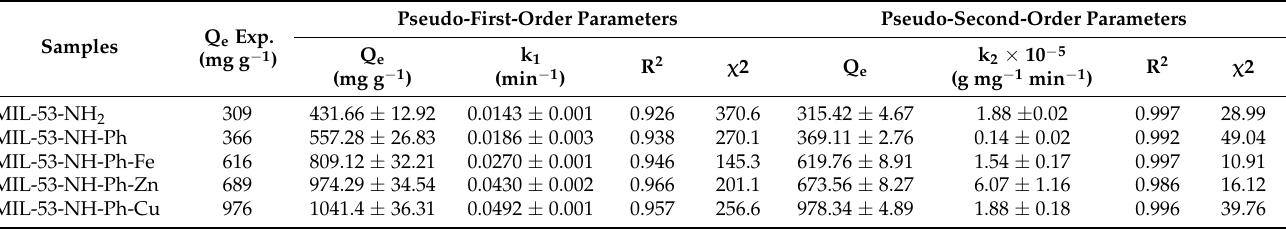
Table 4. Kinetic parameters for carbofuran uptake onto MIl-53-NH 2 , MIL-53-NH-ph, MIL-53-NH-ph- Fe, MIL-53-NH-ph-Zn, and MIL-53-NH-ph-Cu.